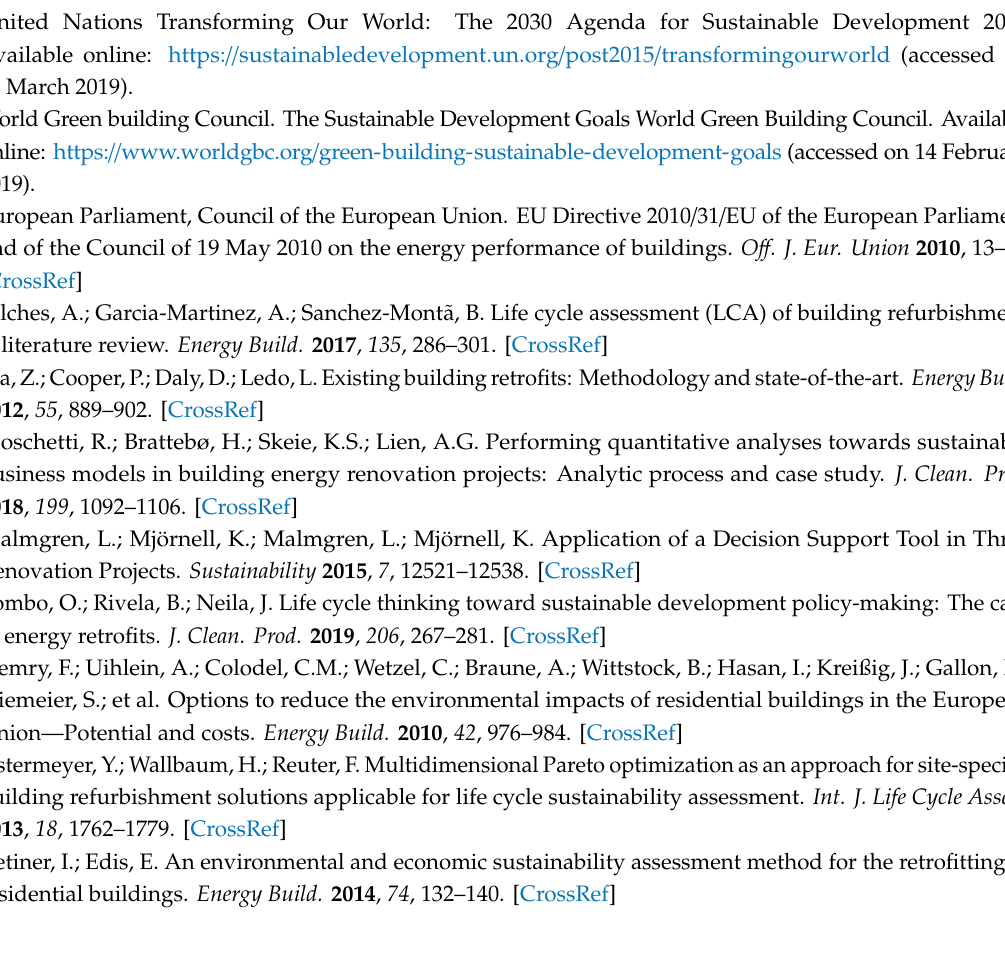
Table S1: Case Study Building Information, Table S2: Renovations Scenarios, Table S3: Materials datasets not listed in the article, Table S4: Fuel use (%) for district heating 2016, Table S5: Greenhouse gas emissions (GHG) emission factors for DH 2016, Table S6: LCC parameters, Table S7: End of life